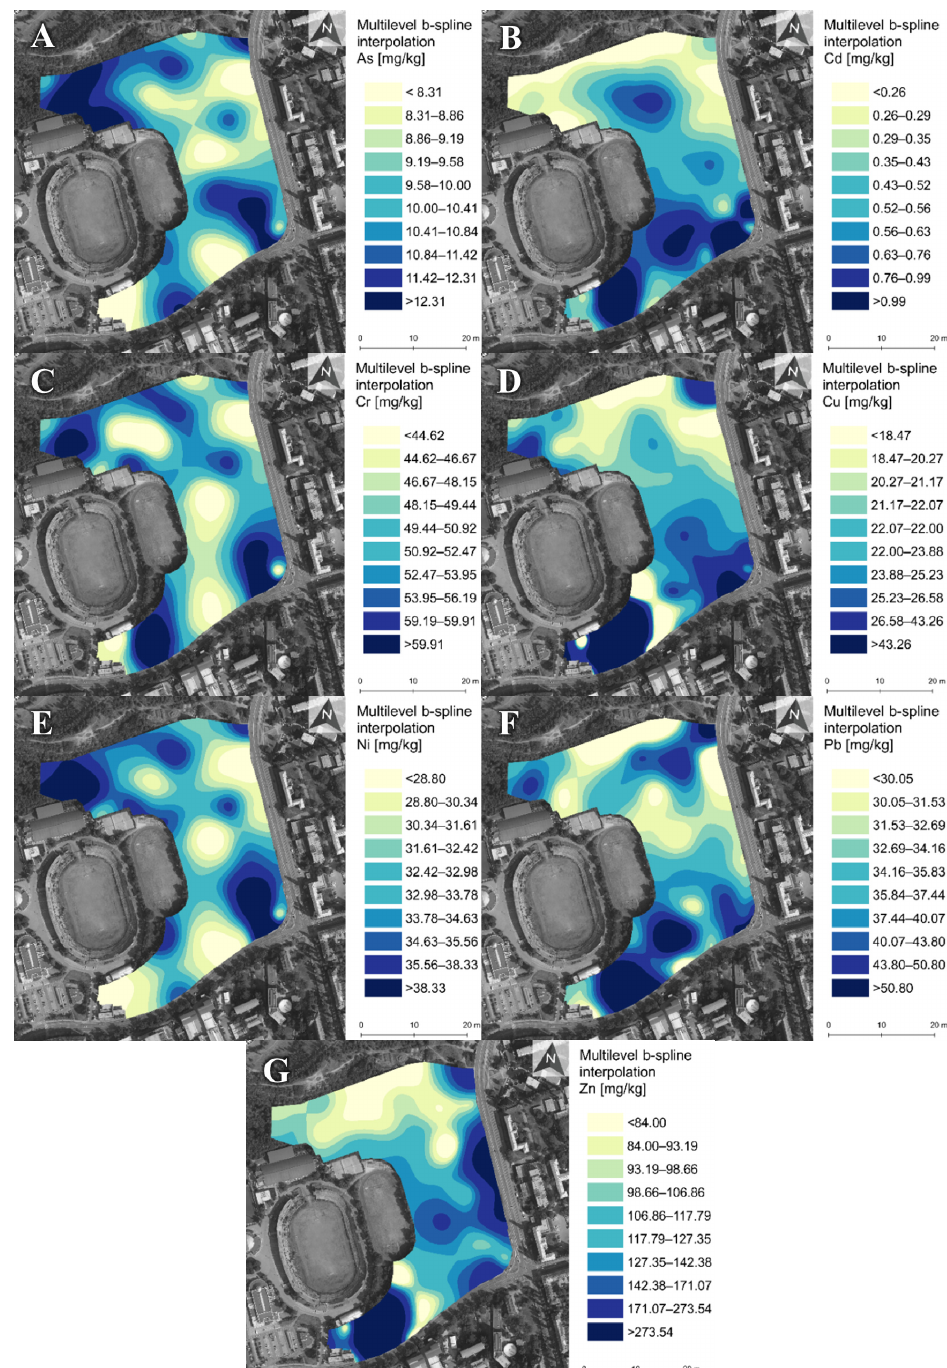
Figure 3. Spatial distribution of As ( A ), Cd ( B ), Cr ( C ), Cu ( D ), Ni ( E ), Pb ( F ) and Zn ( G ) in the botanical garden soils.